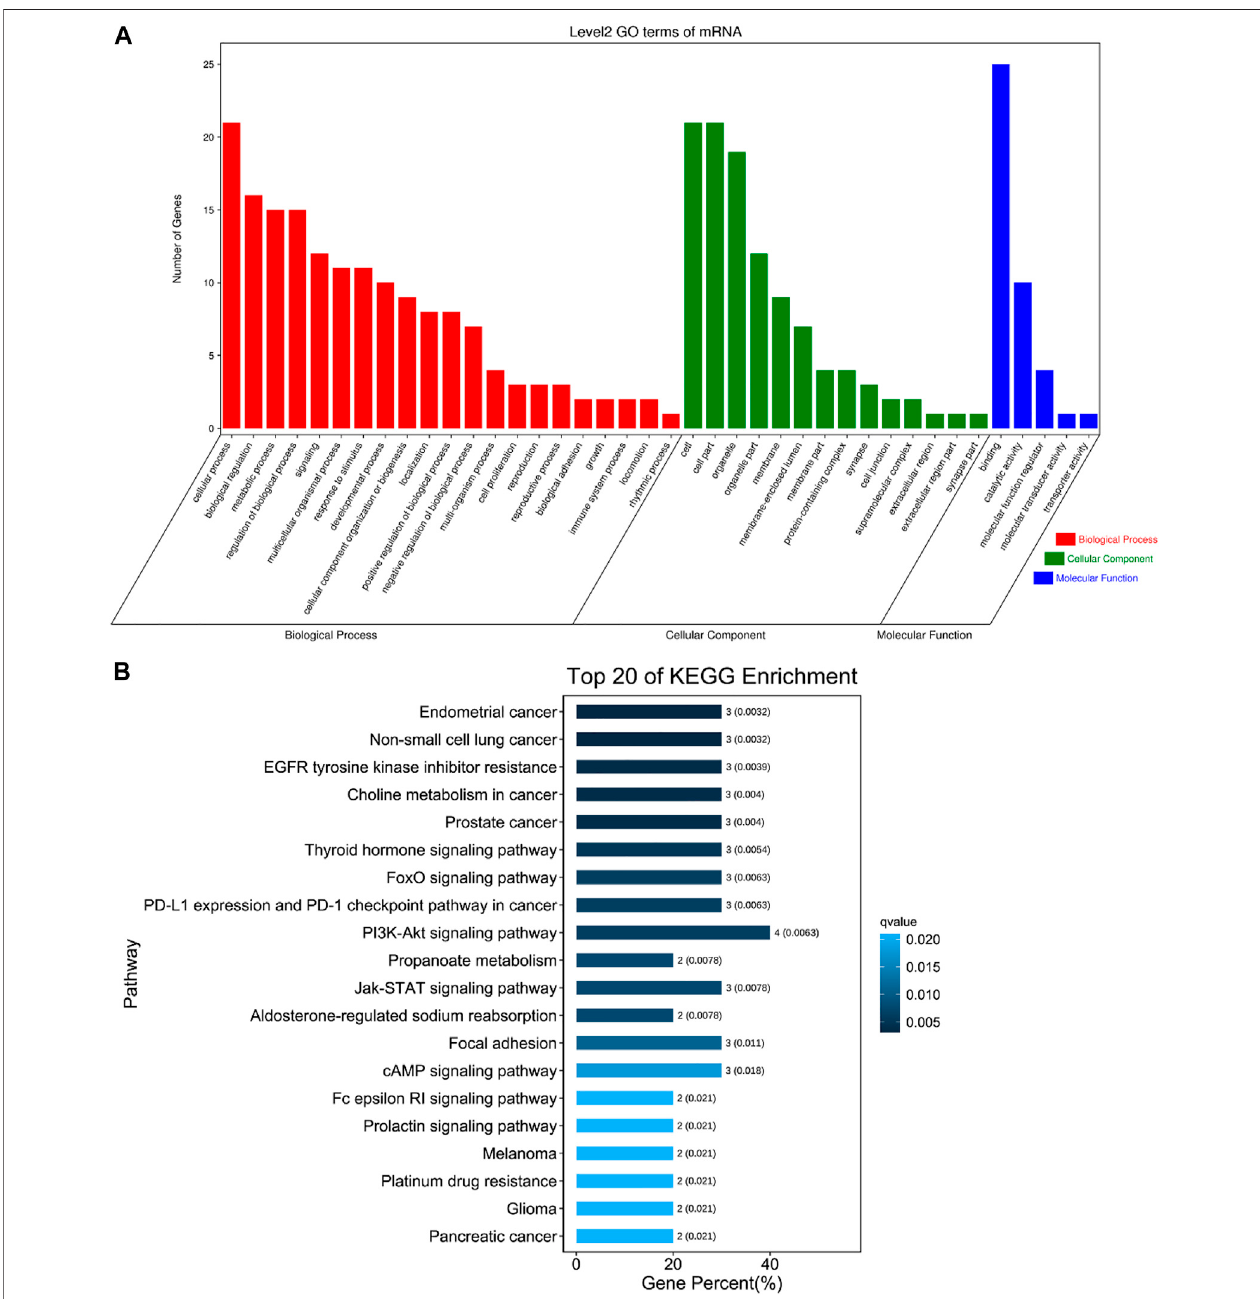
FIGURE6| The fi rst20GOtermsandKEGG. (A) The fi rst20GOtermsofDEcircRNAsrelatedtoskeletalmuscle.TheabscissaisthesecondaryGOterm,andthe ordinateisthenumber ofgenesinthisterm. Differentcolorsshow differenttypes ofGOterms, red representsBiological Process,green represents Cellular Component, blue represents Molecular Function. (B) The fi rst 20 KEGG of DE circRNAs related to skeletal muscle. Using the top 20 pathways with the smallest Q value to make a map, the ordinate is the pathway, the abscissa isthe enrichment factor, the size ofthe column indicates the number ofgenes, the bluer the color, the smaller the Q